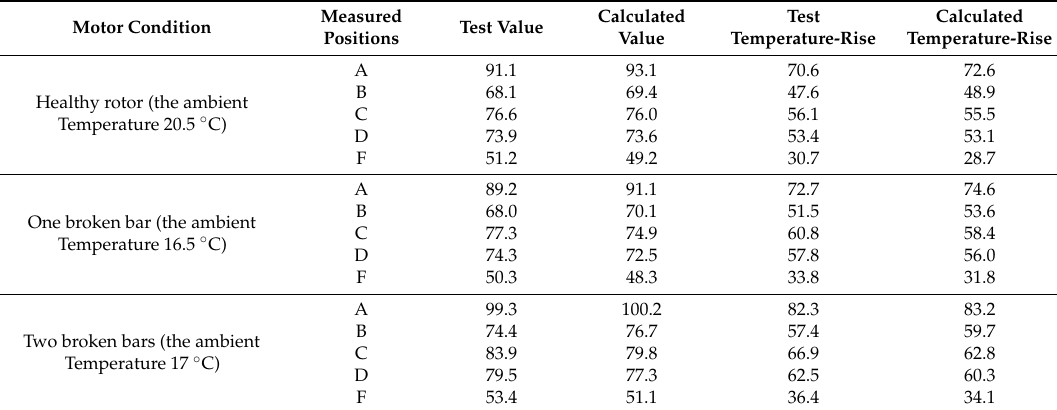
Table 4. Comparison of the temperature value of the measured points (°C). Measured Motor Condition